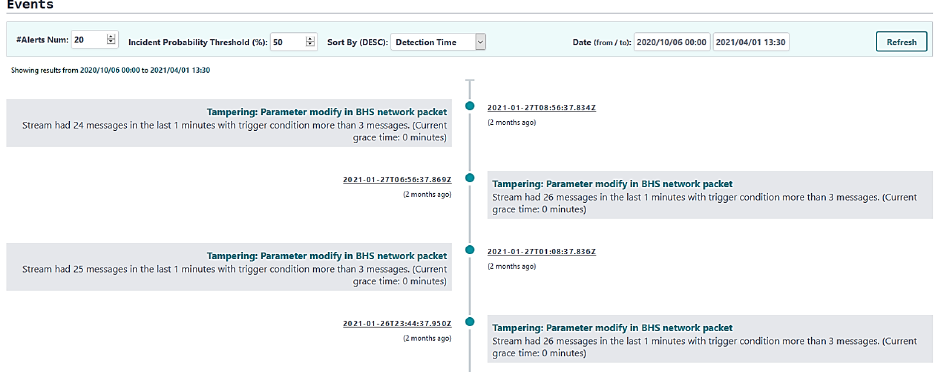
Figure 14. SMS-I Intelligent Dashboard: Events